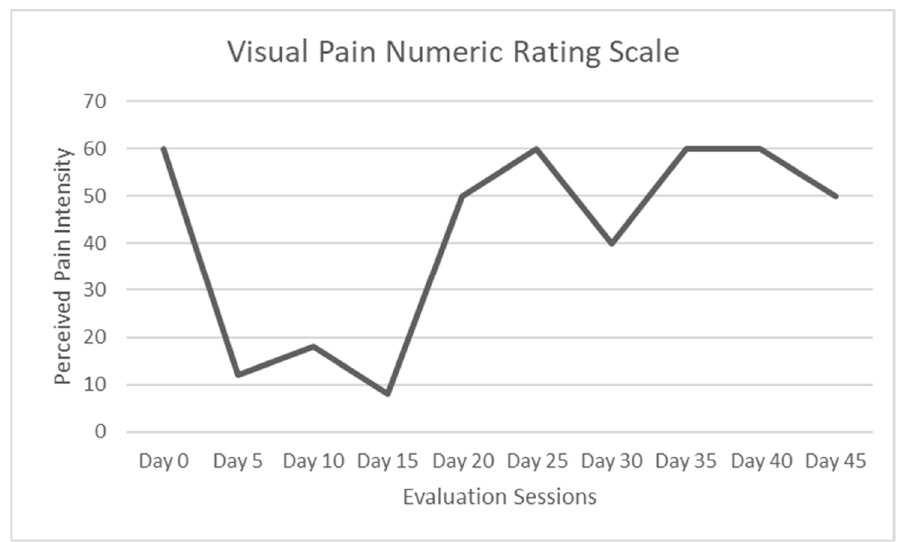
Figure 1. Results of the visual analogue scale during therapy and follow